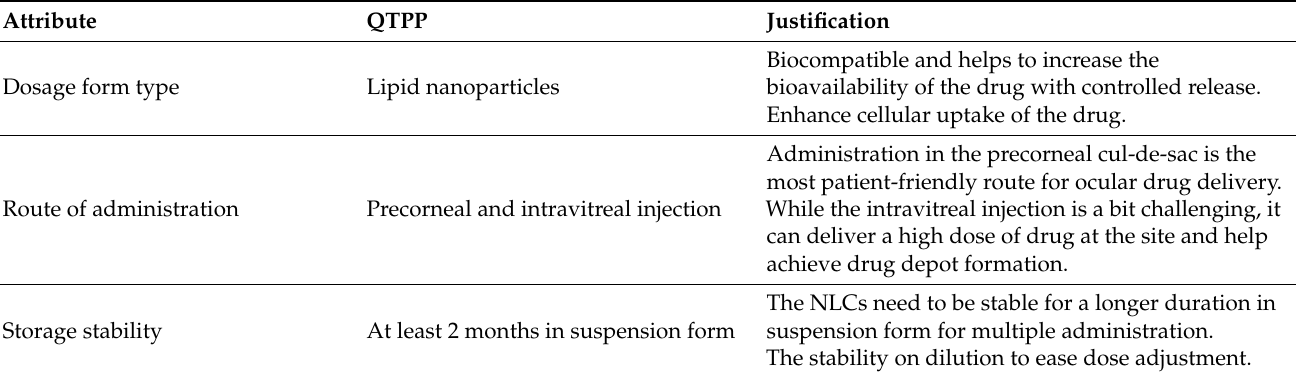
Table 1. Quality Target Product Profile for